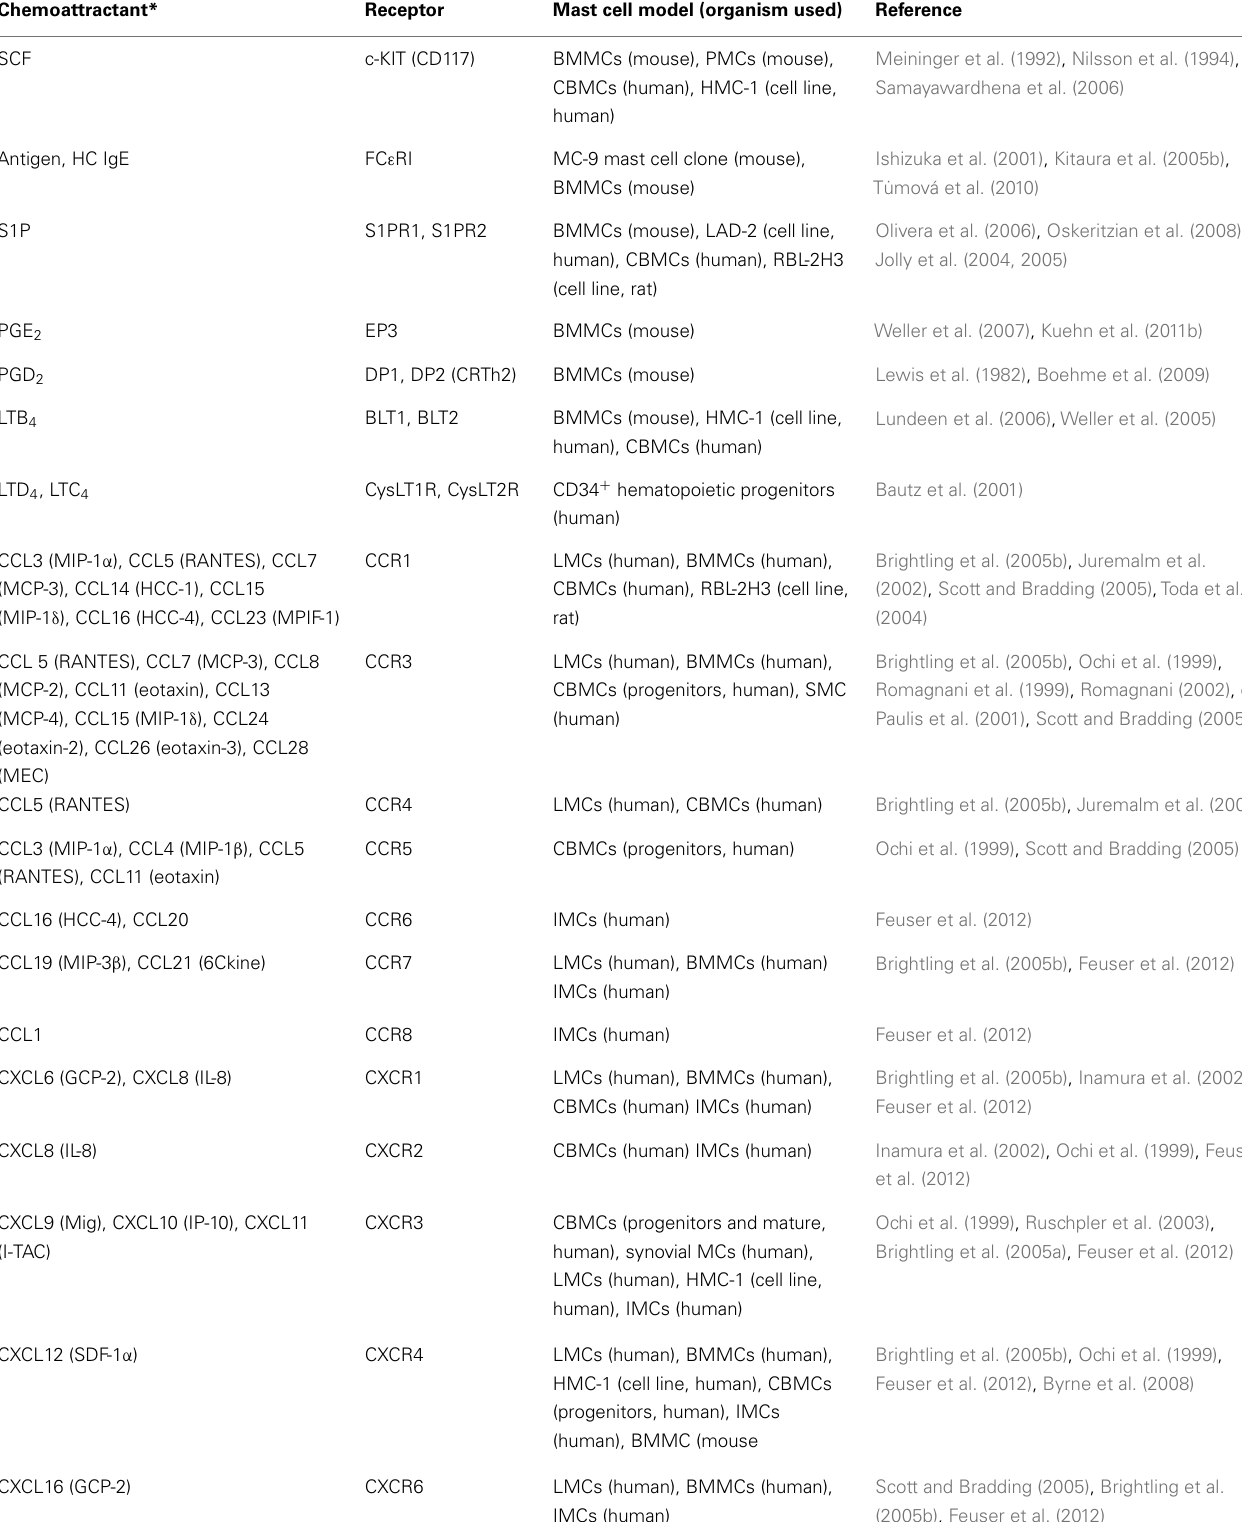
Table 1 | Summary table of different mast cell chemoattractants and their